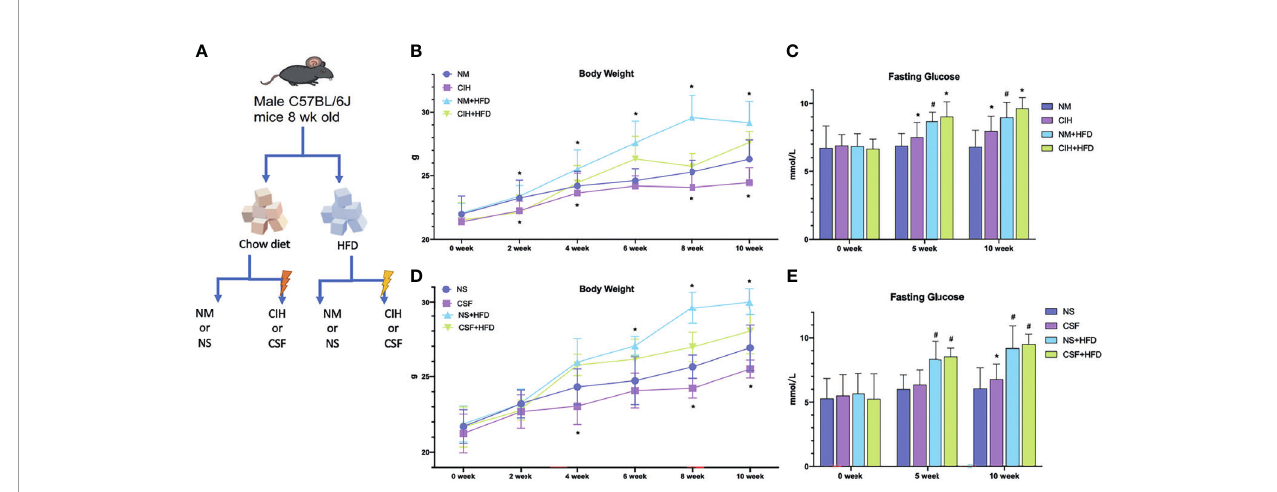
FIGURE 1 | Overall modeling work fl ow and baseline data. (A) CIH and CSF with diet intervention modeling work fl ow and design. (B) Body weights of the chow diet and HFD groups throughout the experiment of CIH exposure. (C) The fasting blood glucose levels of the mice in the chow diet and HFD groups during the period of CIH. (D) Body weights of the chow diet and HFD groups throughout the experiment of CSF exposure. (E) The fasting blood glucose levels of the mice in the chow diet and HFD groups during the period of CSF. Data are expressed as mean ± SEM. Group differences were assessed by using the Mann ‐ Whitney U test. *P < 0.05 when comparing NM/NS and CIH/CSF groups (NM/NS group vs CIH/CSF group, NM+HFD/NS+HFD group vs CIH+HFD/CSF+HFD group). # P < 0.05 when comparing chow diet and HFD groups (NM/NS group vs NM+HFD/NS+HFD